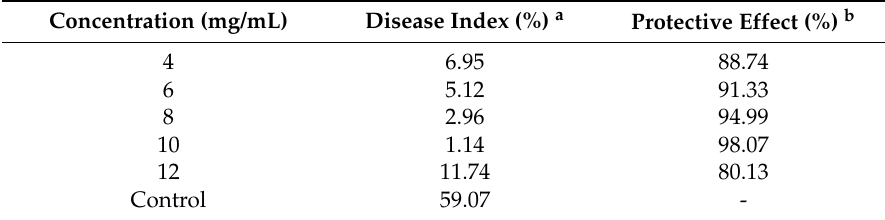
Table 8. Screening the protective effect of BAEO against Blumeria graminis.